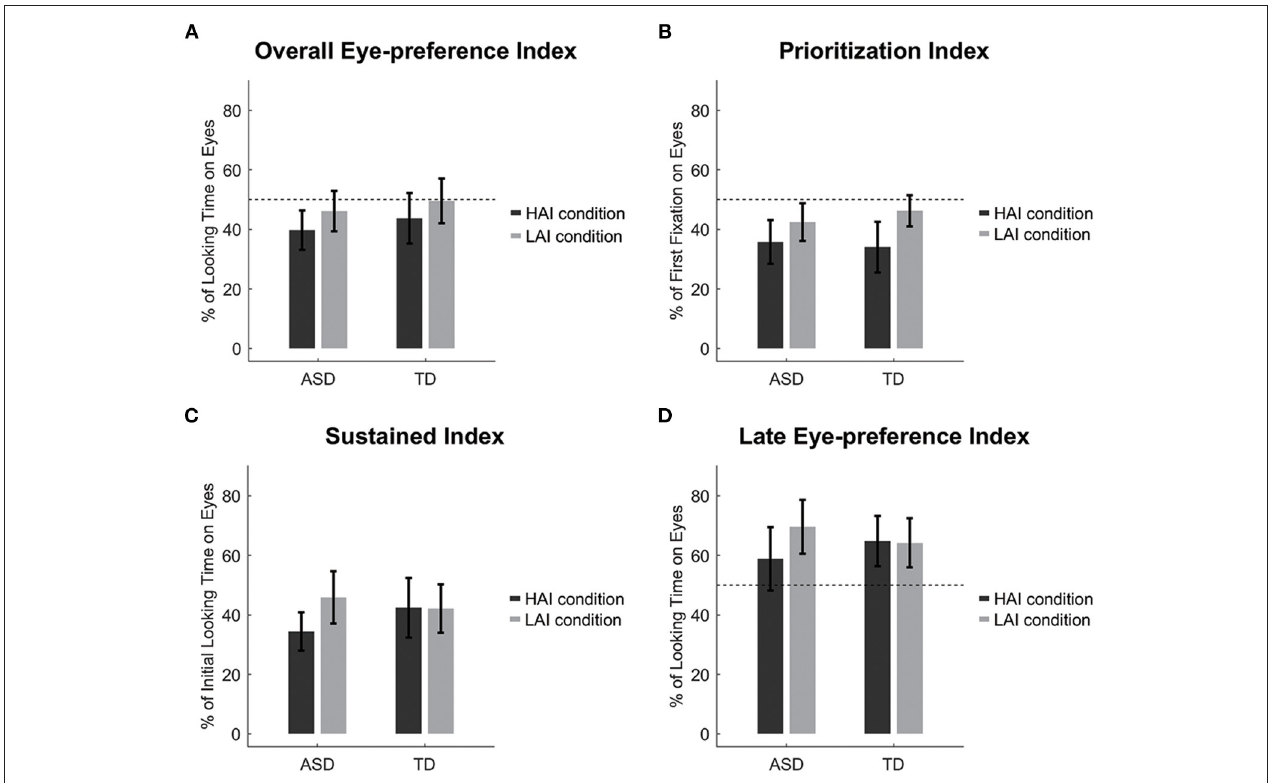
FIGURE 2 | Eye movement results. ( A ) Overall eye-preference index; ( B ) Prioritization Index; ( C ) Sustained index; ( D ) Late eye-preference index. Dashed lines represent the chance level and error bars represent standard